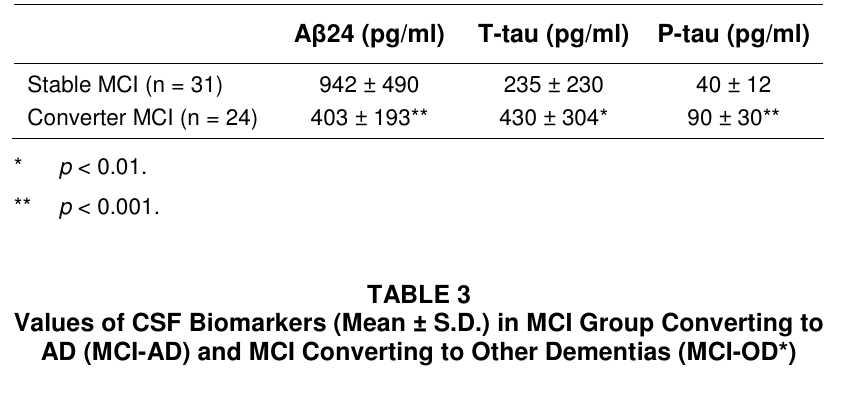
Values of CSF Biomarkers (Mean ± S.D.) in MCI Group Converting